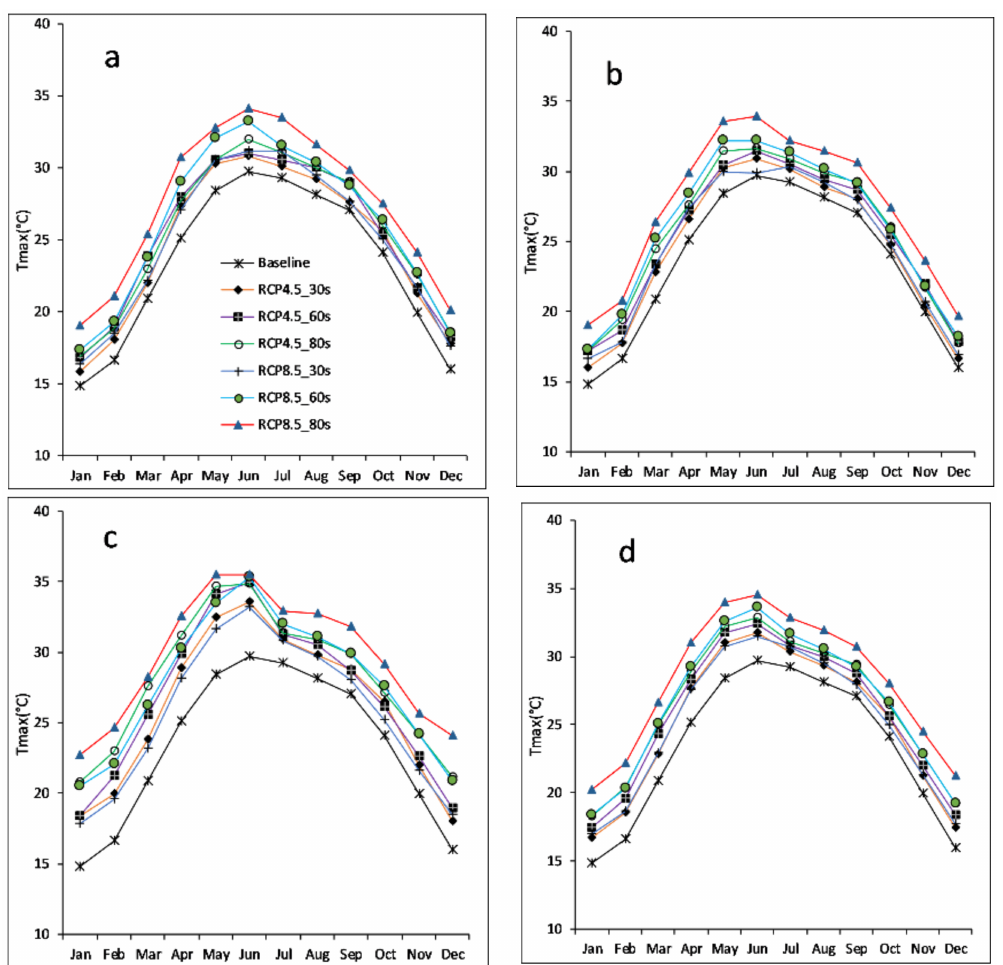
Figure 5. Comparison of monthly mean T max between observed (1975–2005) and projected climate during the three future periods. ( a ) BCC-CSM1.1; ( b ) CCSM4; ( c ) MIROC-ESM; and ( d )